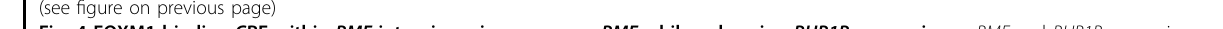
Fig. 4 FOXM1-binding CRE within BMF intronic region represses BMF while enhancing BUB1B expression. a BMF and BUB1B genomic landscape from UCSC genome browser with tracks of FOXM1 32 and H3K27Ac 33 ChIP-seq data. b BMF promoter-reporter assay in siNeg- and siFOXM1-depleted MCF-7 cells. c BMF transcript levels in CRE#1 CRISPR/Cas9-deleted MCF-7 polyclonal cell population. d BMF transcript levels in CRE#2 CRISPR/Cas9-deleted MCF-7 polyclonal cell population. e BMF transcript levels in CRE#3 CRISPR/Cas9-deleted MCF-7 cells immediately after sorting. f BMF transcript levels in CRE#3 CRISPR/Cas9-deleted and siFOXM1-depleted MCF-7 cells immediately after sorting. g Genomic PCR validation for the ability to generate CRE#3 CRISPR/Cas9-deleted polyclonal cell population only in a BMF KO background. h Enhancer reporter assay for CRE#3 in siNeg- and siFOXM1-depleted MCF-7 cells. i BUB1B transcript levels in CRE#3 CRISPR/Cas9-deleted MCF-7 cells immediately after sorting. j 4C-seq replicates of neonatal HDFs with a viewpoint in CRE#3 (red). BMF promoter and BUB1B promoter interactions with CRE#3 are highlighted (orange). Data information: in b , f , h data are mean ± S.D. from n = 3 or n = 4 independent experiments; **** p ≤ 0.0001 (two-tailed one-way ANOVA and Tukey ’ s multiple comparison test). In c , d data are mean ± S.D. from n = 3 and n = 2 independent experiments; ns, p ≤ 0.05